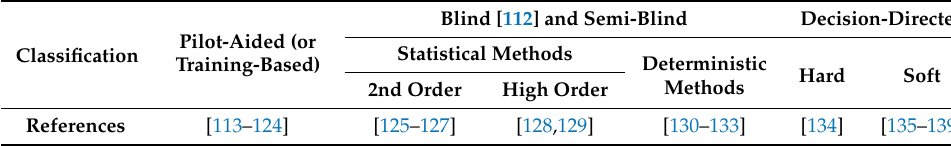
Table 6. MIMO-OFDM channel estimation algorithms classification.